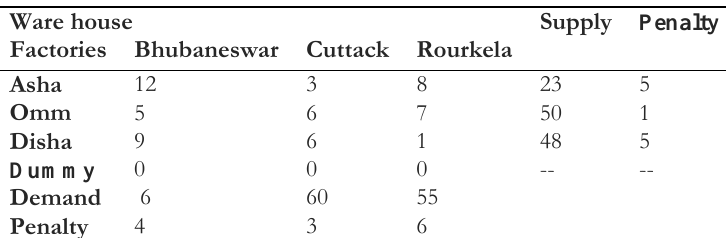
Table 6. After strike out of 3 rd Row the penalties allocation.